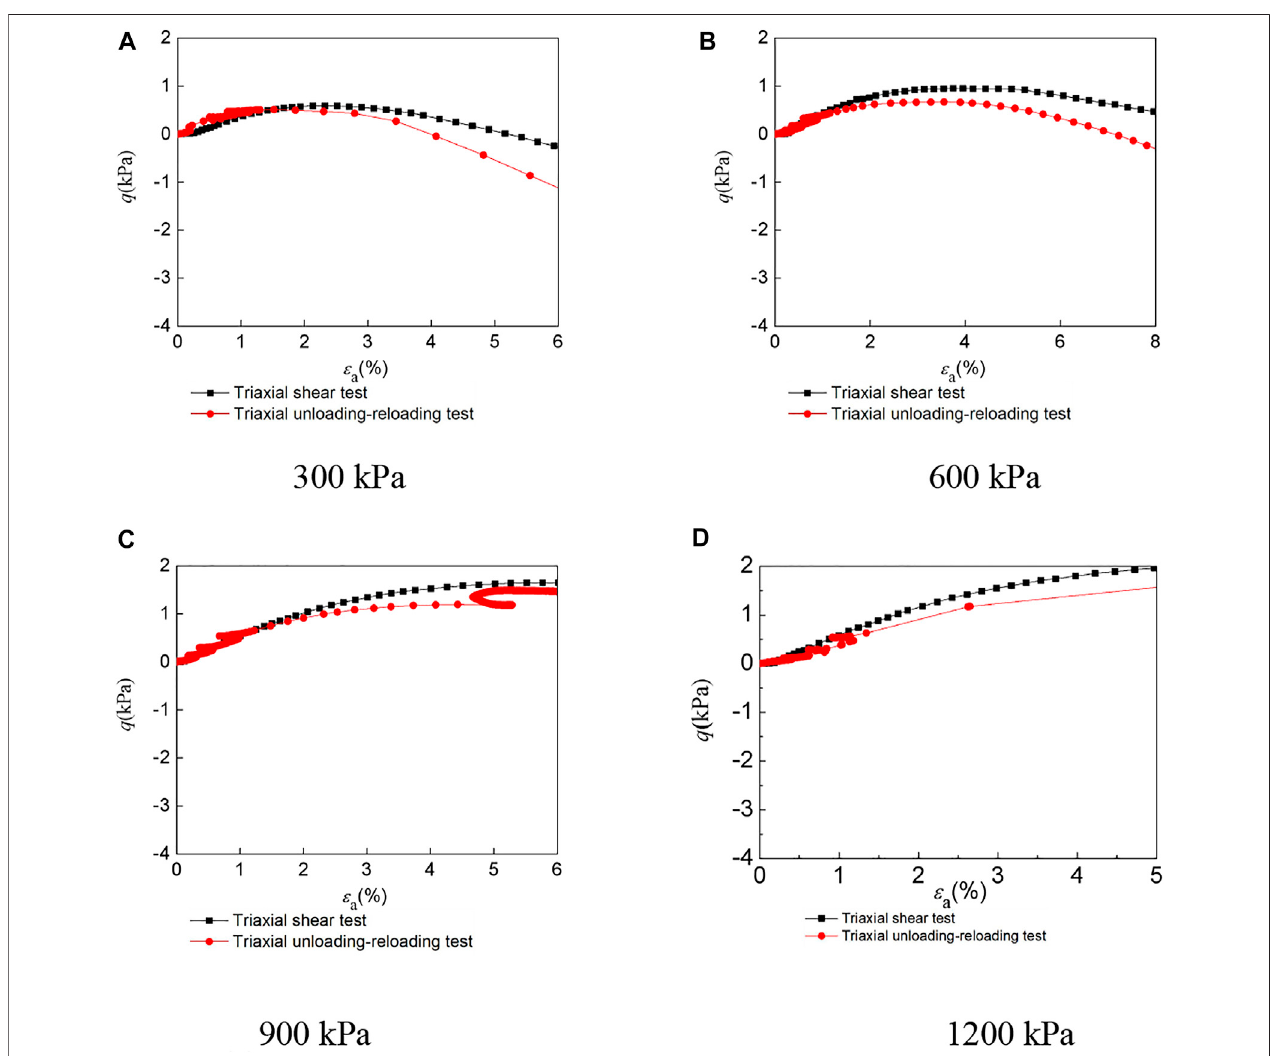
FIGURE5| Volumetricstrain – axialstraincurvesofLCSGmaterialwithcementedcontentof20kg/m3underdifferentcon fi ningpressures. (A) 300 kPa (B) 600 kPa (C) 900 kPa (D) 1,200 kPa.